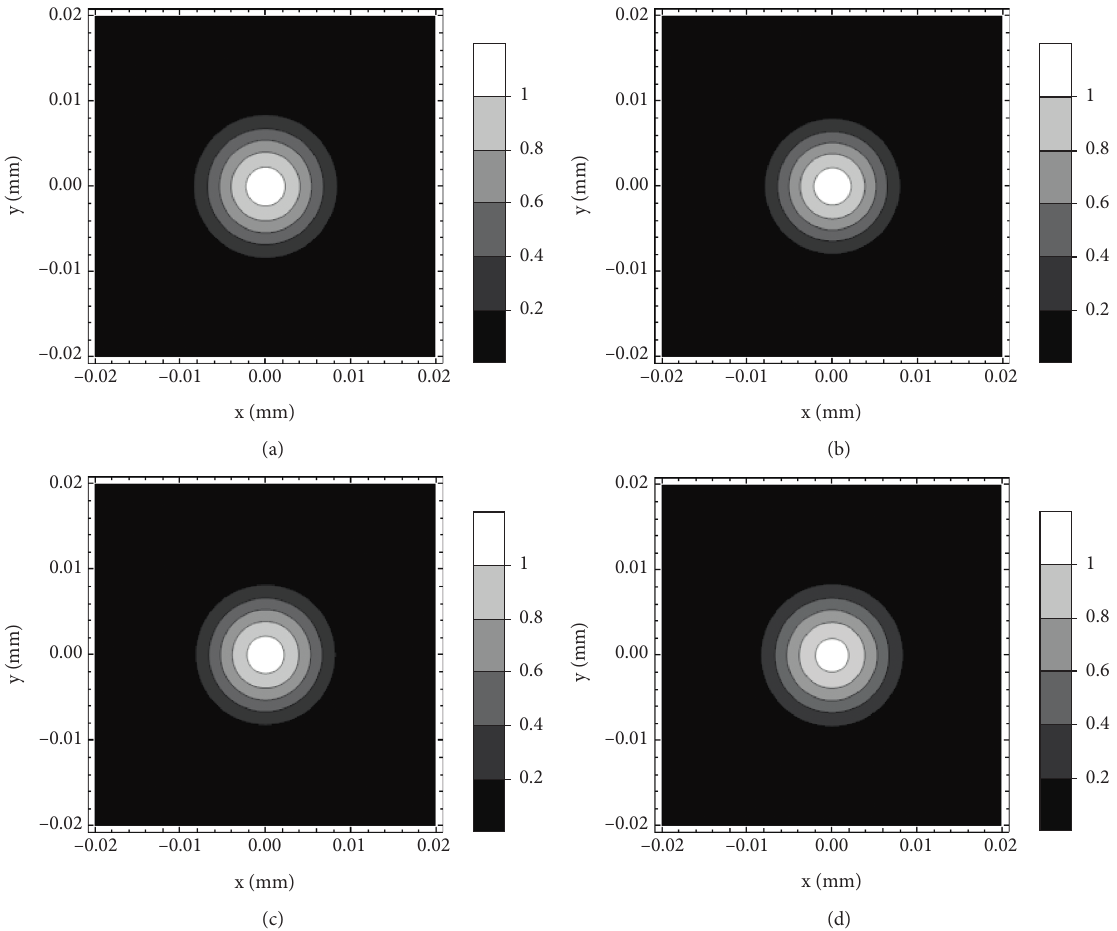
Figure 6: Intensity patterns of the partially coherent Lorentz beam with incident beam widths of w coherence widths σ � 8mm at different propagation distances in along focal length of logarithmic axicon. (a) z � 100mm. (b) z � 140mm. (c) z � 180mm. (d) z �